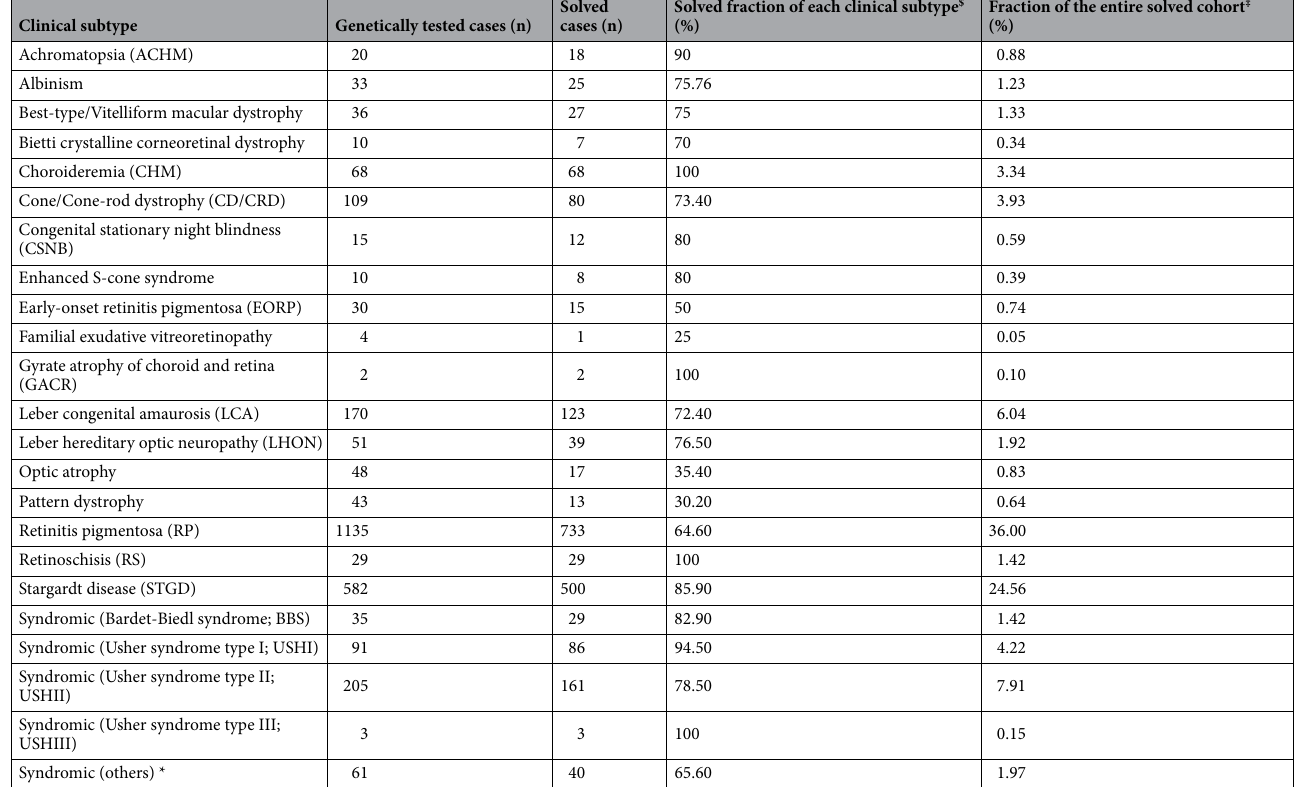
Table 1. Clinical composition of the molecularly diagnosed cohort. $ Solved fraction of genetically tested cases with the corresponding clinical subtype. ‡ Fraction of the solved cohort (n = 2036) that belongs to each clinical subtype. *Alström syndrome (n = 4); Batten disease (n = 2); CHARGE syndrome (n = 2); Retinal degeneration and microcephaly (n = 1); Coffin-Siris syndrome (n = 1); Jalili syndrome (n = 2); Joubert syndrome (n =